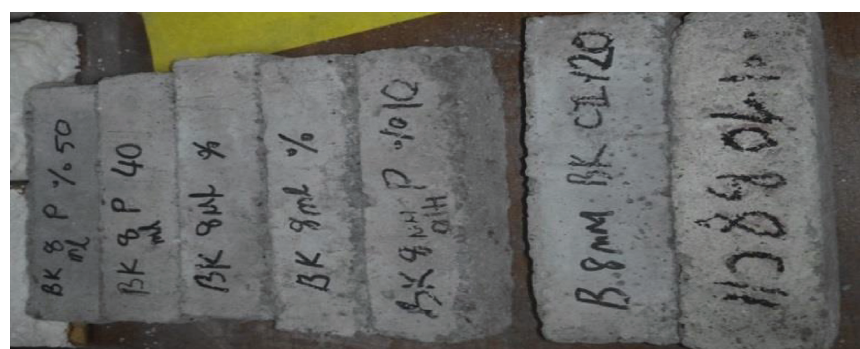
Figure 4: After water absorption percentage (WAP) experiment, photographs of some samples produced in this study. Note: the acronym of BK in this figure is in Turkish, indicating